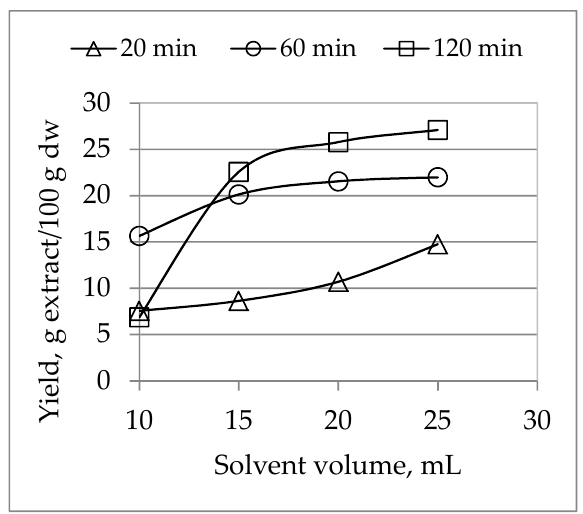
Figure 1. Effect of the solvent volume on the yield of extracts . Figure 1. E ff ect of the solvent volume on the yield of extracts.